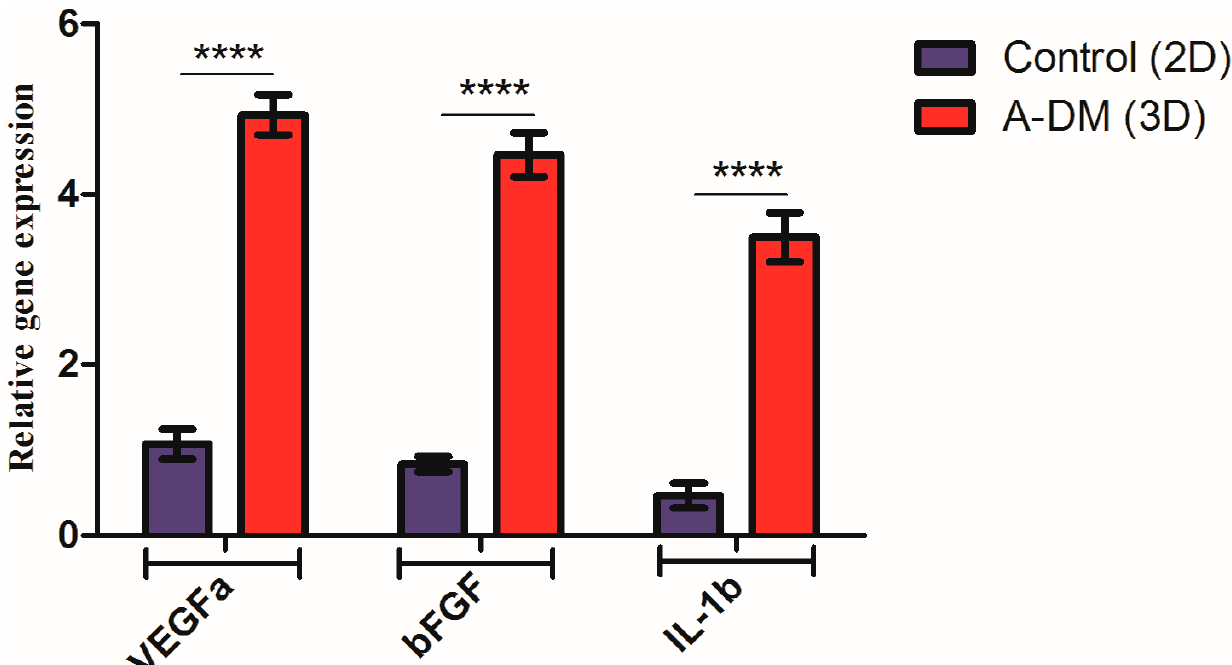
Figure 4. In vitro angiogenesis assay. A higher expression of VEGFa, bFGF, and IL_1 β observed in the FADM-WJMSC group (**** p < 0.0001).